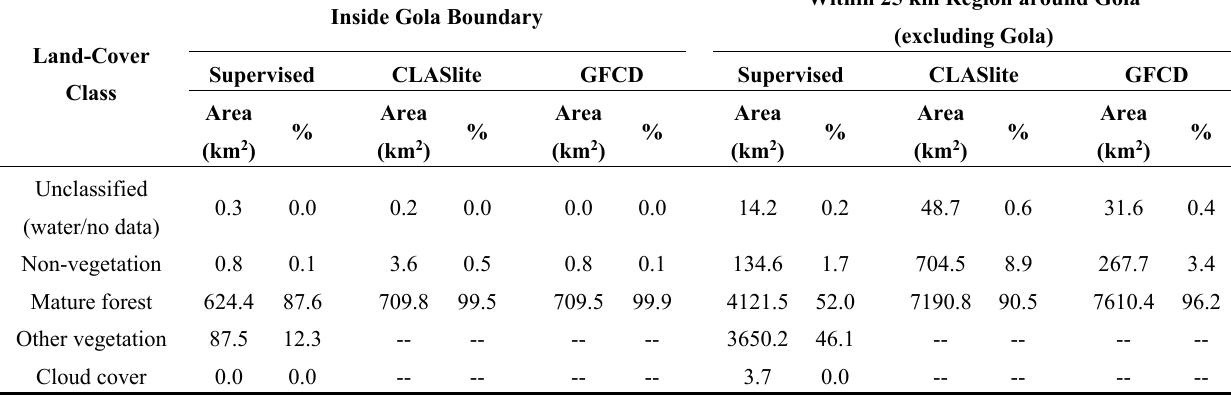
Table 1. Summary area statistics for the three land-cover maps of Gola and its surrounding 25 km region in early 2001 resulting from supervised classification in ENVI, classification in the Carnegie Landsat Analysis System lite (CLASlite), and classification derived from the Global Forest Change dataset (GFCD). Values represent both total area coverage (km 2 ) and percentage of total land area of four different land-cover types plus cloud cover (other vegetation and cloud cover were only distinguished in the supervised classification). Total area of Gola is 710 km 2 , while the 25 km region around Gola, excluding Gola, represents an area of roughly 7900 km 2 .